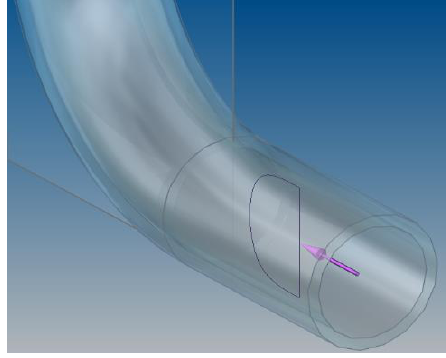
Figure 2. 0-degree dividing plane.